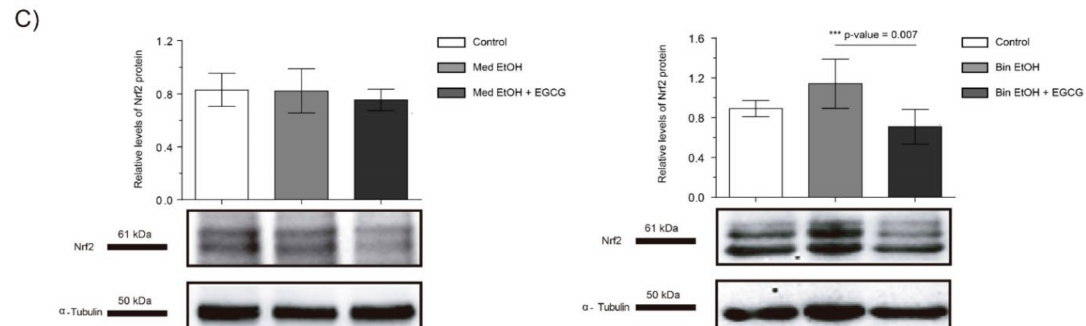
Figure 5. Nuclear factor erythroid 2-related factor 2 (Nrf2) immunofluorescence (Alexa 488 in green for the Nrf2 biomarker, and 4 (cid:48) ,6-diamidino-2-phenylindole (DAPI) to stain the nuclei in blue) in the hippocampus ( A ) and cerebellum ( B ). Boxed regions in the hippocampus and cerebellum are shown at higher magnification using 63 × Oil Immersion. Nrf2 protein analysis in brain lysed samples ( C ) under the selected experimental conditions (PAE and EGCG treatment). ( A ) Nrf2 quantification in whole sections of the dentate gyrus using a 10 × objective lens. ( B ) Nrf2 quantification in whole sections of the cerebellum using a 10 × objective lens. ( C ) Representative Western blot of Nrf2 expression analyzed under the various experimental conditions. Protein levels were normalized using α -tubulin as load control. Arbitrary units express “fold change”. At least five samples from different litters were used from each group. For intergroup comparisons, the Kruskal– Wallis test (Dunn’s test for multiple comparisons) was used. Asterisks denote the level of significance: ** p -value < 0.01. *** p -value < 0.005.